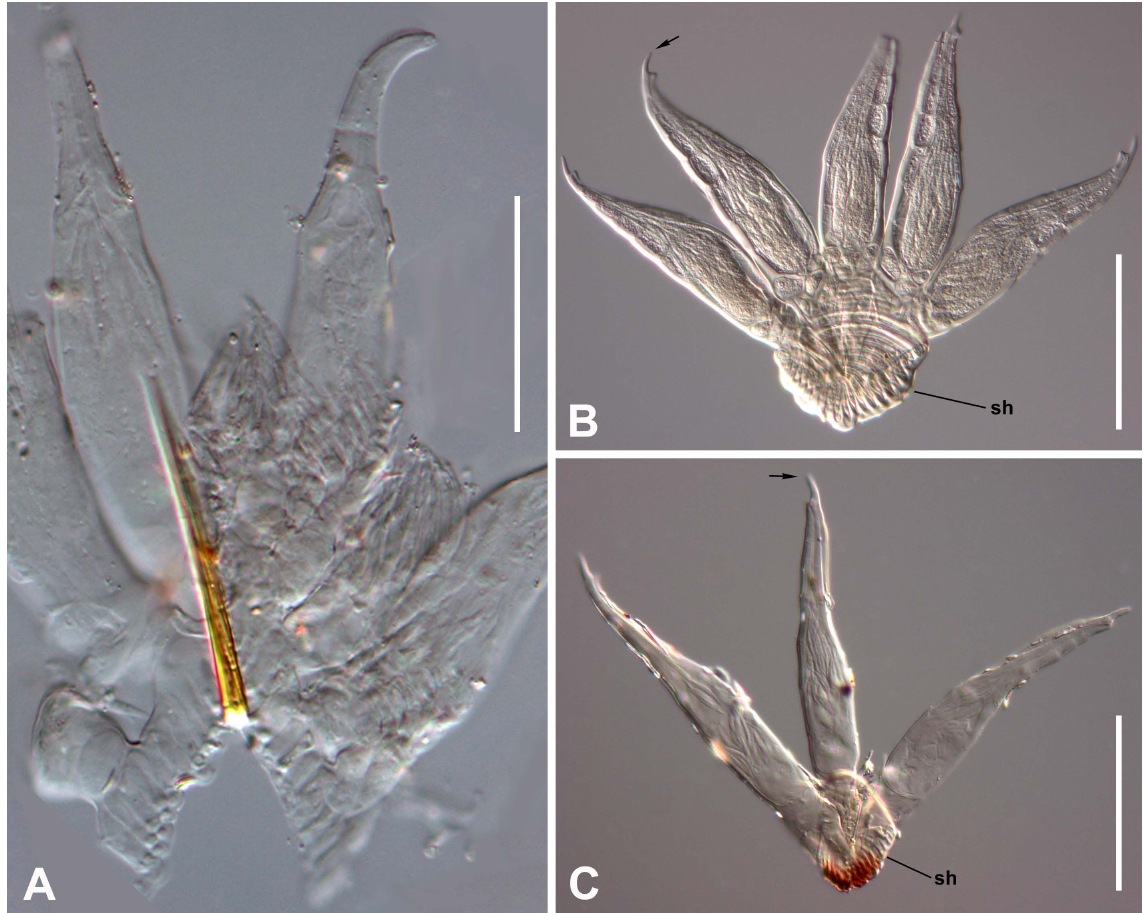
Fig. 1. Herpomyces spp. A . H. ectobiae Thaxt.; mature thallus. – B . H. periplanetae Thaxt.; mature thallus showing the distal acute tooth-like outgrowth on the perithecium (arrow), and shield (sh). – C . H. stylopygae Speg.; mature thallus showing the distal acute tooth-like outgrowth on the perithecium (arrow), and shield (sh). Scale bars: A = 50 µm; B–C = 100 µm. Photographs from slides ZMUC C-F- 124041 (A), ZMUC C-F-123751 (B), and ZMUC C-F-124039